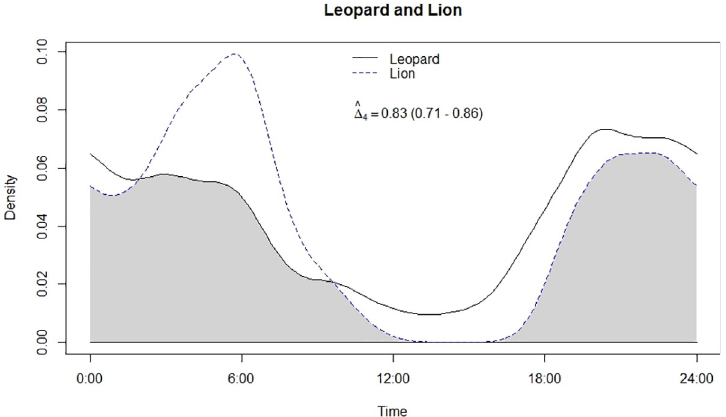
Fig 2. Temporal overlap between leopard and lion.